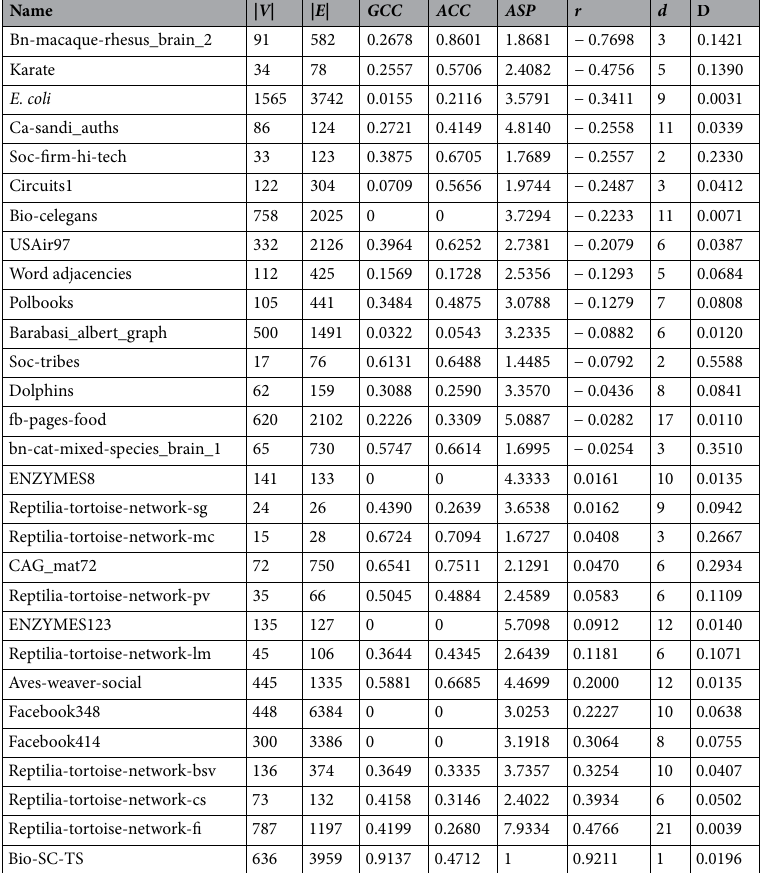
Table 1. Network properties of 29 networks used in the analysis; | V |: number of nodes in the network, | E |: number of edges in the network, r : Assortativity coefficient value, GCC & ACC: Global and average clustering coefficients, ASP : Average shortest path, d : diameter, and D : graph density. The networks are sorted according to the assortativity level; ( 0 > r ≥ − 1 ) for disassortative networks, ( 1 ≥ r > 0 ) for assortative